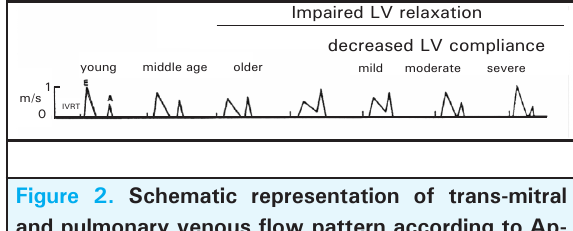
Figure 2. Schematic representation of trans-mitral and pulmonary venous flow pattern according to Ap - pelton and Hatle 25. With increasing age the E/A ra- tio